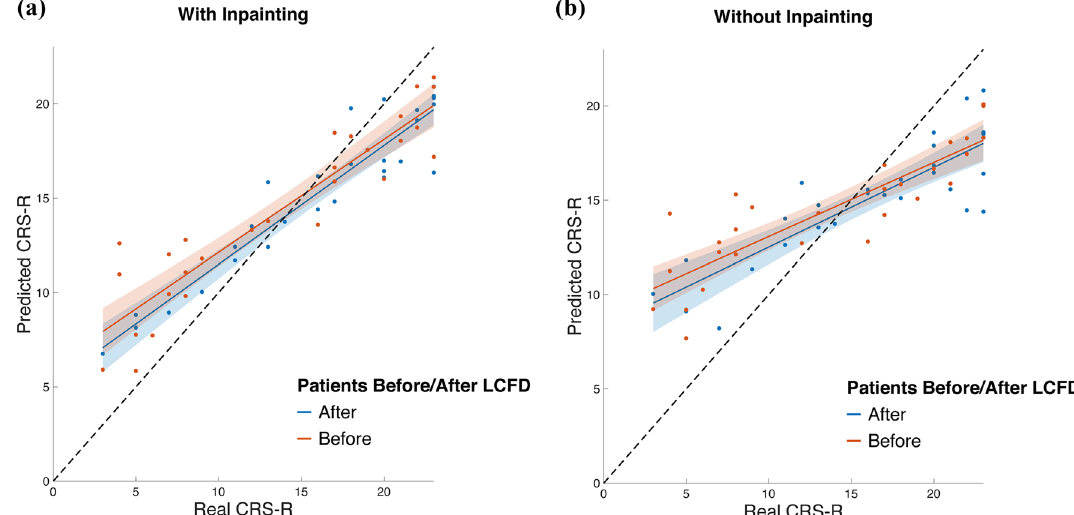
Fig. 7 Regression results using the LASSO method. a Segmentation is implemented using the inpainting method. b The inpainting method is not used during